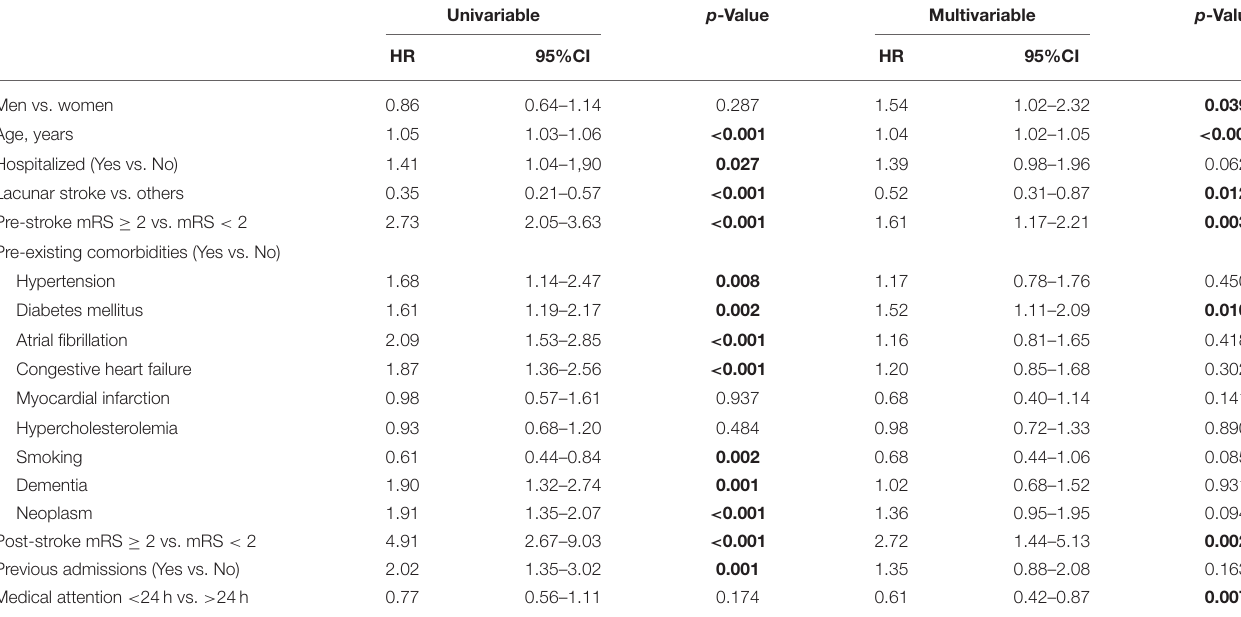
TABLE 4 | Univariable and multivariable readmission/death analyses.